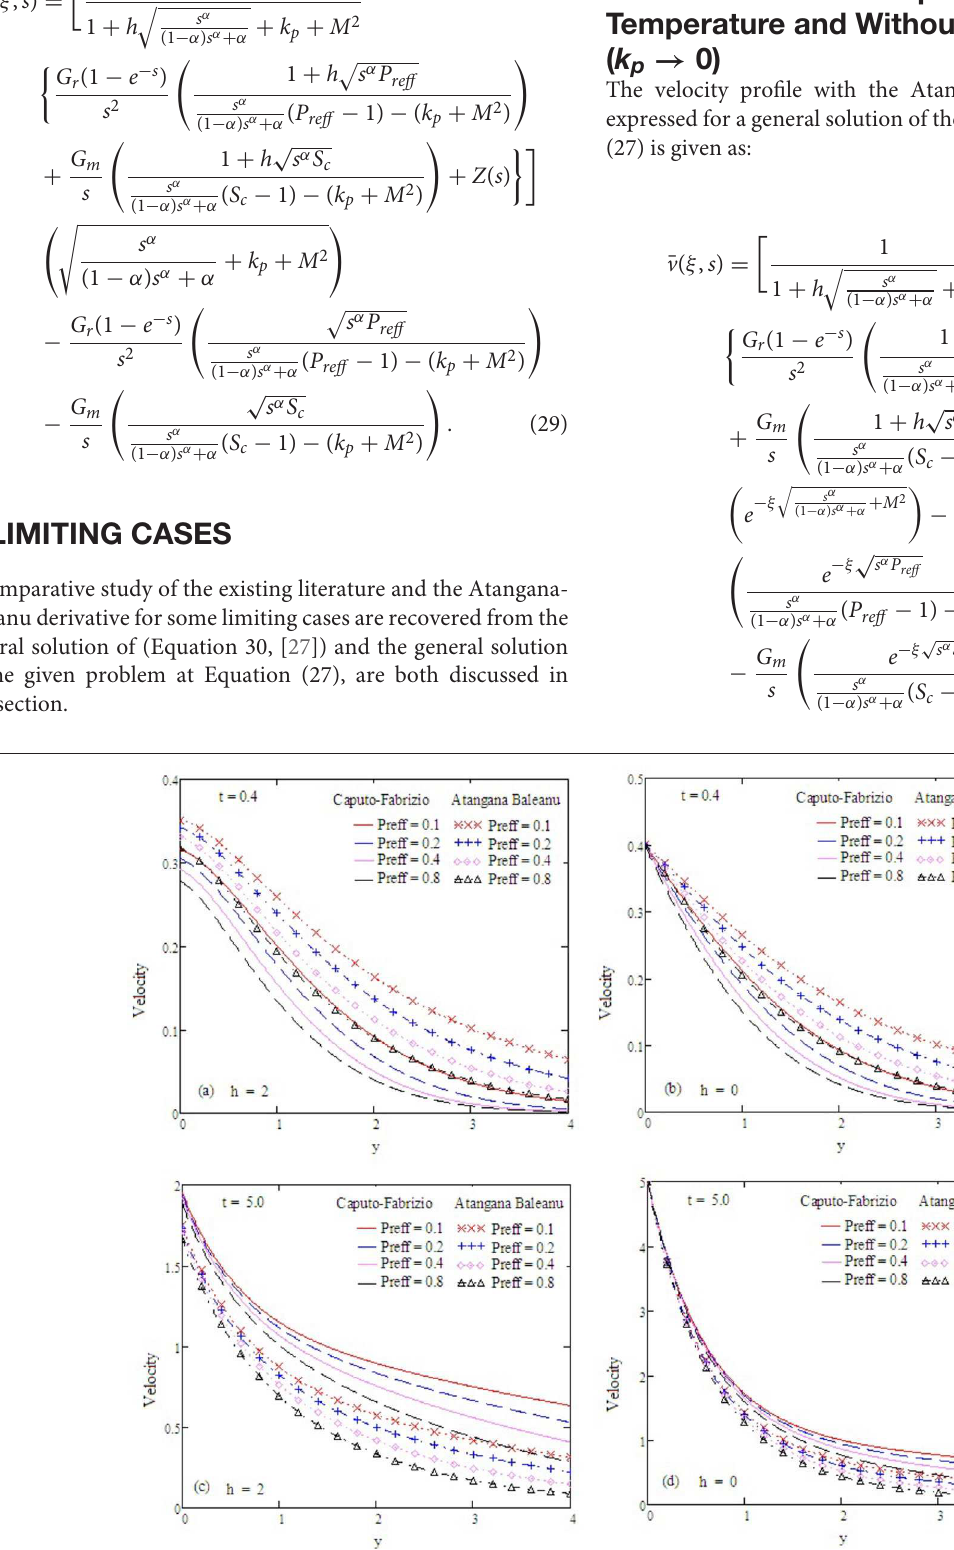
Frontiers in Physics |